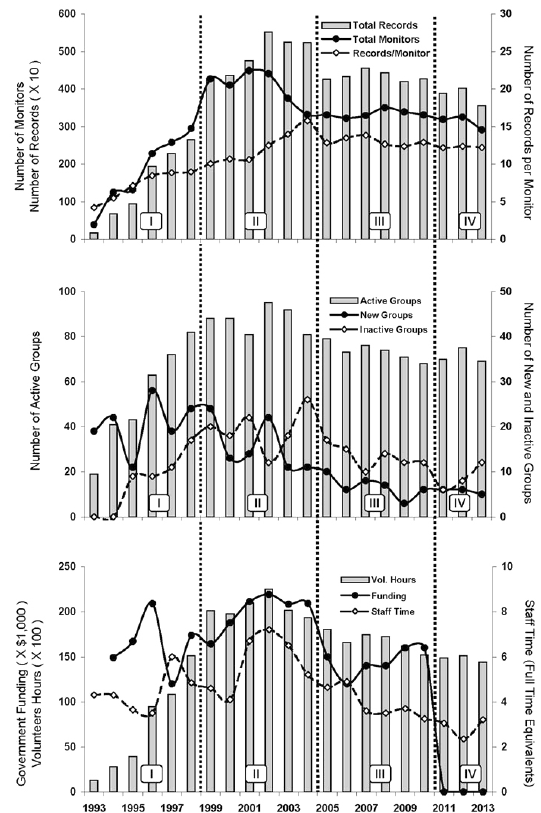
Fig. 2 . Alabama Water Watch program indicators. (A)